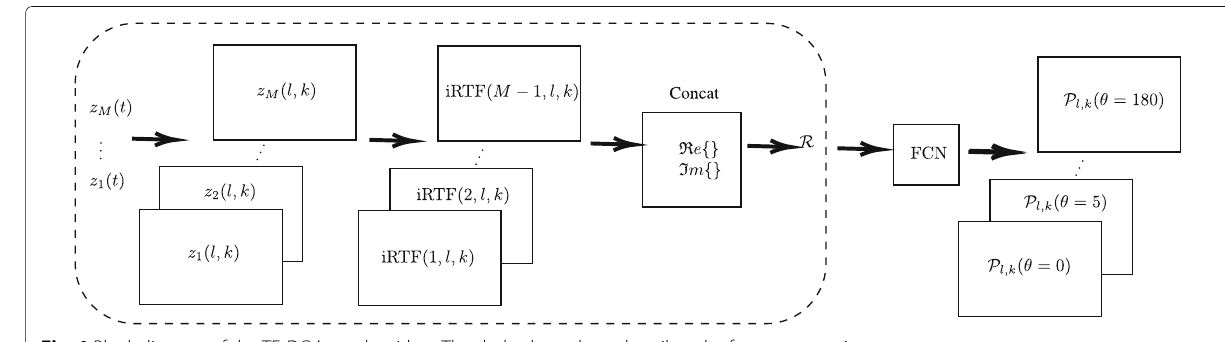
Fig. 1 Block diagram of the TF-DOAnet algorithm. The dashed envelope describes the feature extraction step